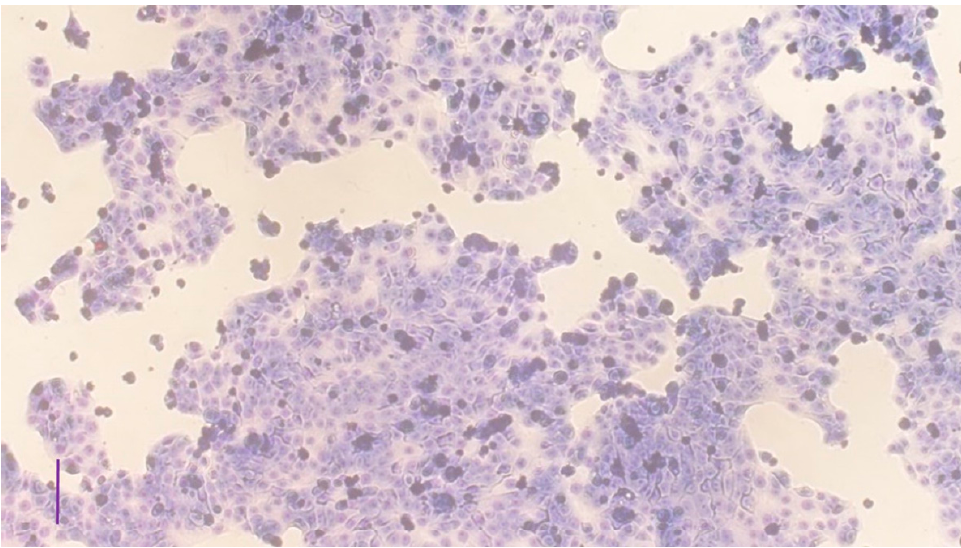
Figure 1. Uroepithelial cell culture on day 1 after plating stained by Giemsa (bar = 100 µm).